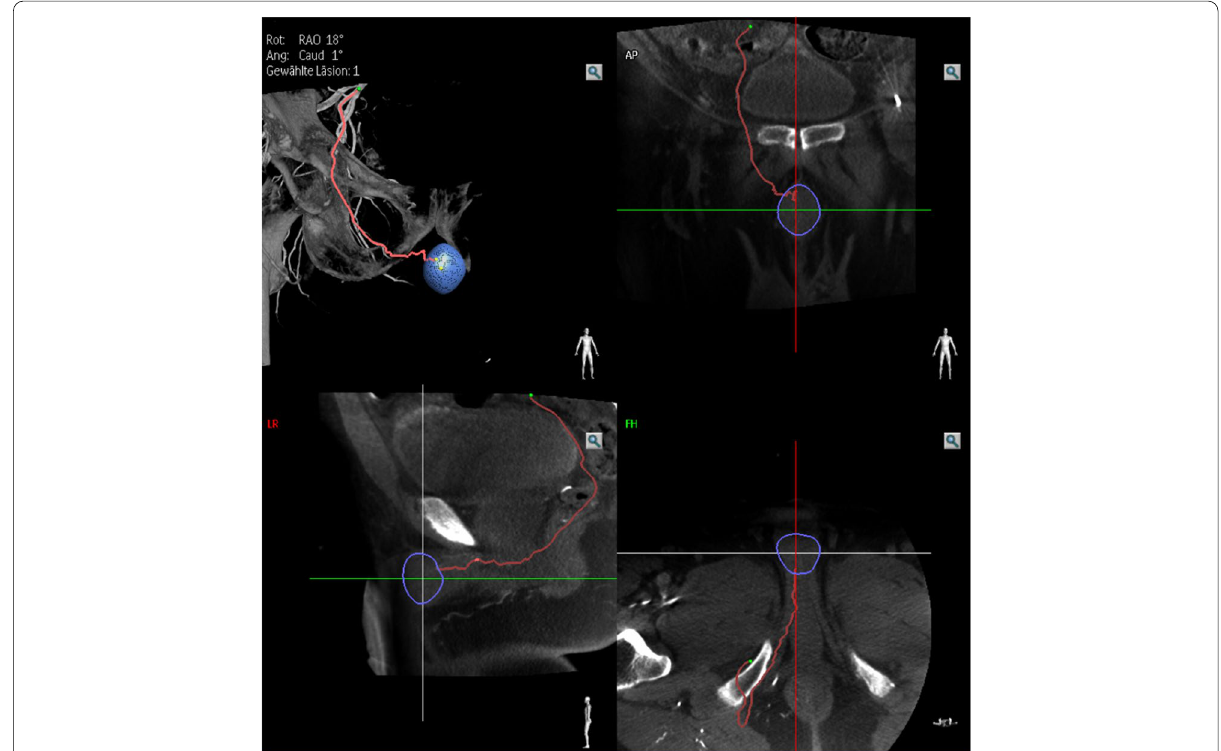
Fig. 2 A three-dimensional road map from the tip of the diagnostic catheter to the navigation target (blue circle) is created by the software